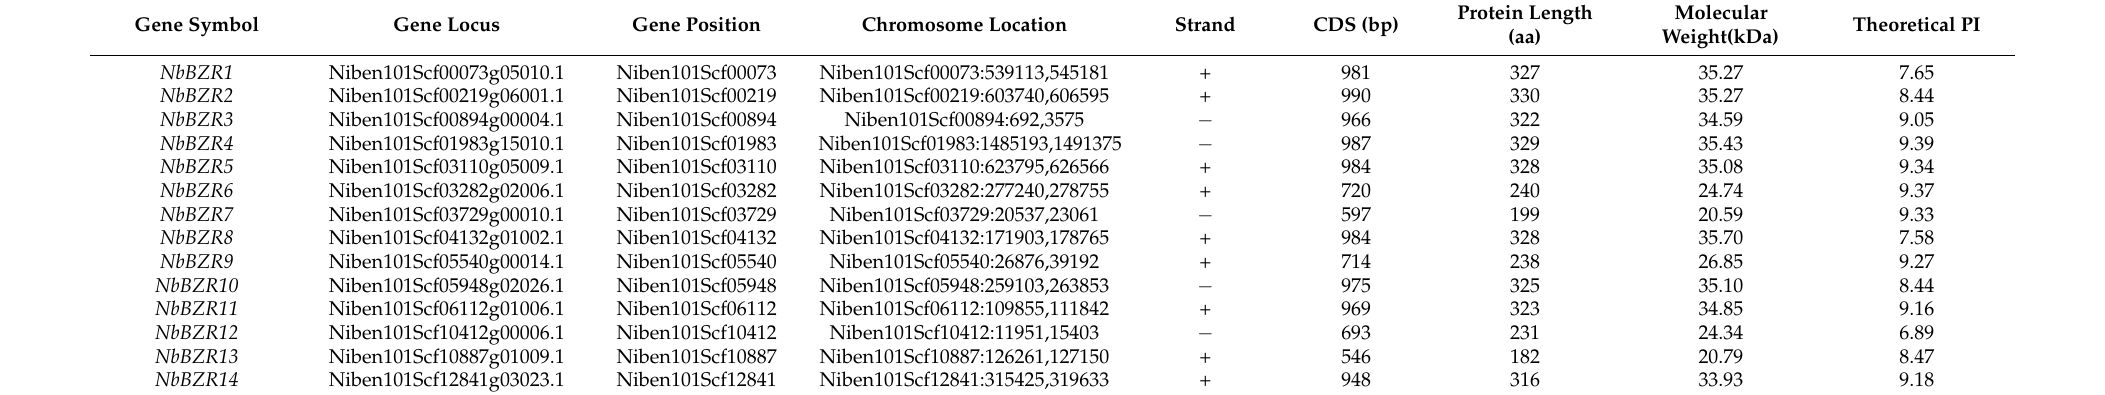
Table 1. Detailed information of the 14 predicted BZR proteins in N.